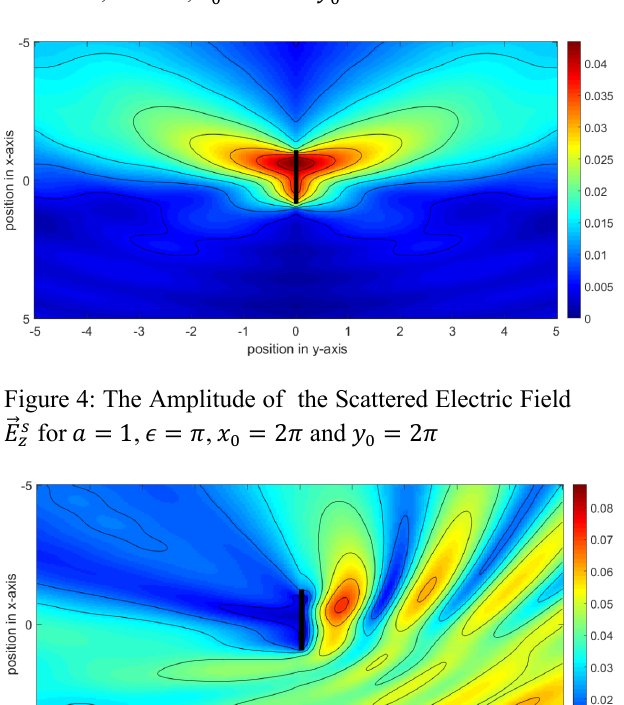
Figure 3: The Amplitude of the Total Electric Field 𝐸Q⃗ AN for 𝑎 = 1 , 𝜖 = 2𝜋 , 𝑥